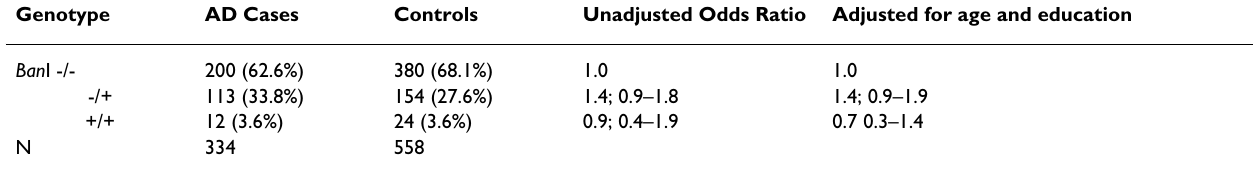
Table 2: Genotype frequencies of the TP73 exon 5 ( Ban I) polymorphism in AD cases and controls Genotype